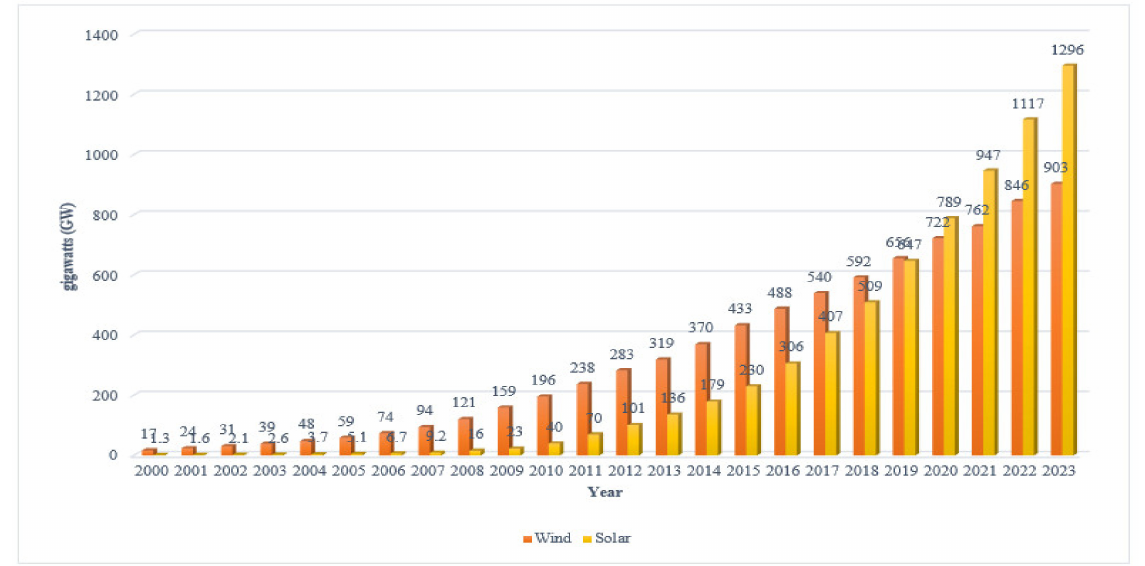
Figure 2. Generation of electricity with wind and solar energies [81].